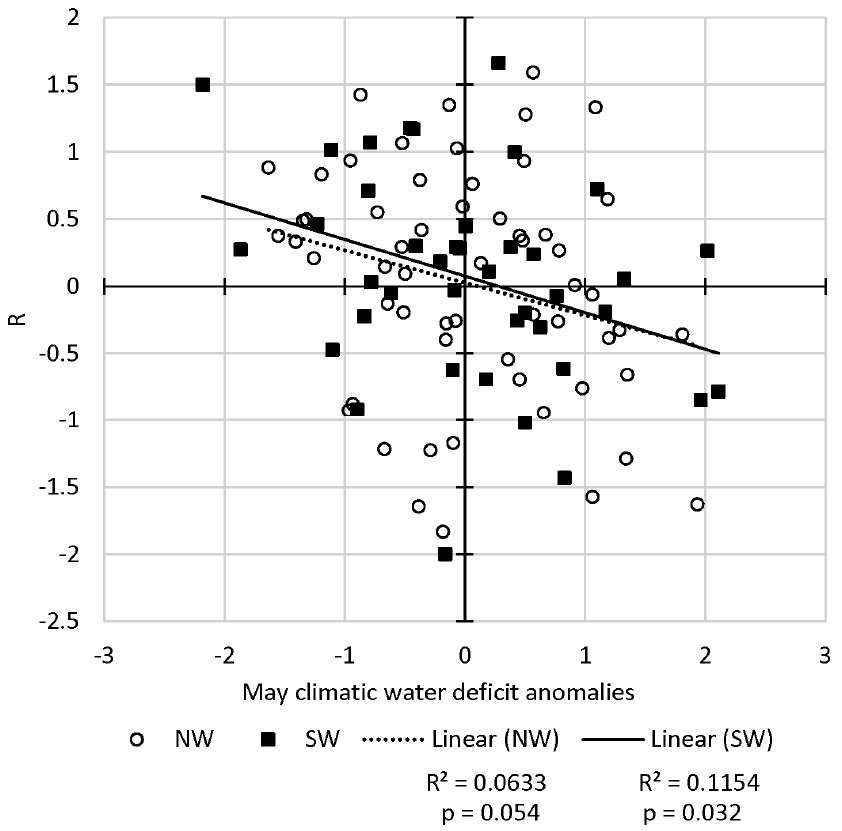
Figure 7. Western spruce budworm defoliation area growth rate R versus standardized anomalies of May climatic water deficit (Northwest (NW): p = 0.054; Southwest (SW): p = 0.032). Solid squares indicate data from years and regions in the Southwest, and hollow circles indicate data from years and regions in the Northwest. The solid line is the trend line of data from the Southwest regions, and the dotted line is the trend line of data from the Northwest regions.